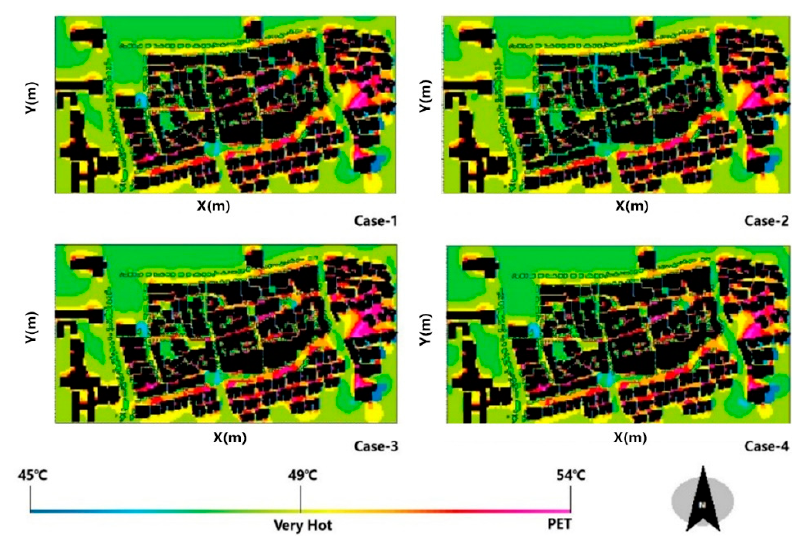
13 of 18 Figure 17. The new cases: Various types of different coverage ratios. In case-1, as mentioned above, the buildings in the pedestrianized zone did not exceed three stories. This case aimed to increase building height to understand its cooling effect, in which the three-story building coverage ratio was increased to 63.3% of the area. In case-2, the tree coverage ratio was increased to 22% in order to better understand its influence. As in case-2, in case-3, the grass coverage ratio was increased to improve outdoor thermal comfort and evaluate its cooling effect in accordance with the local design specification. Case-4 changed the existing pavement material to assess its cooling effect and determine its potential to increase the outdoor energy efficiency. 3.3. The PET Improvement ( ∆ PET) of New Cases Figures 18 and 19 show the improvement of PET the study area based on the new cases. The